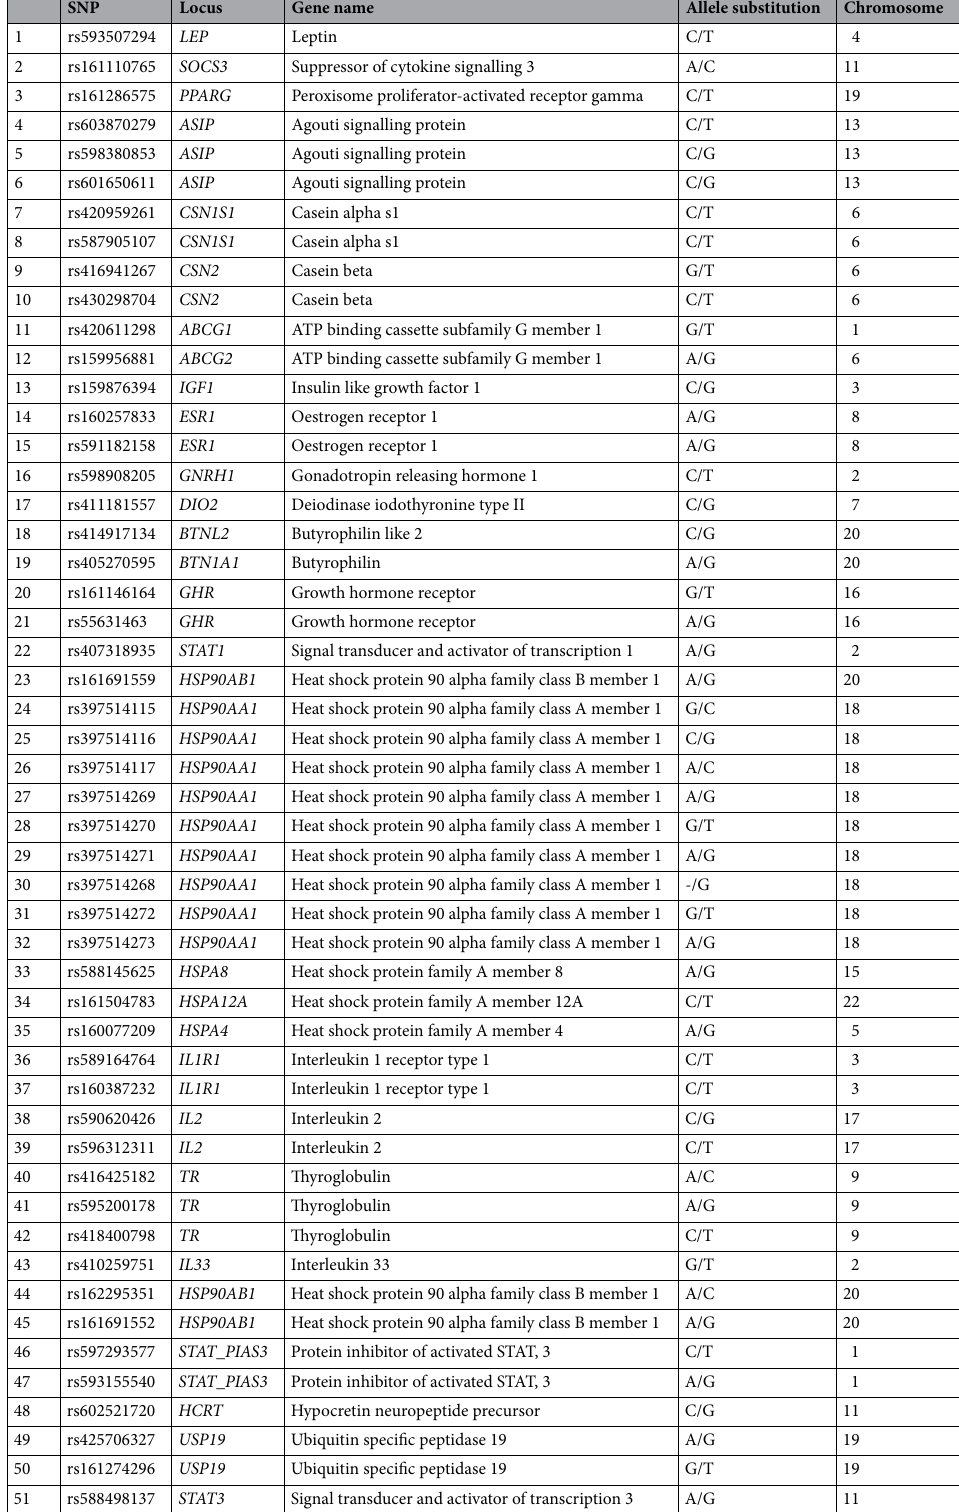
Table 3. Selected SNPs used for studying thermotolerance adaptation genes in various sheep